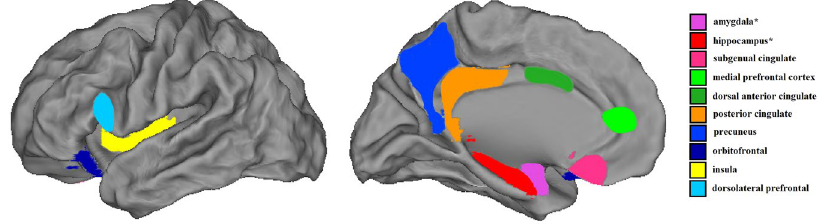
Figure 2. Regions-of-interest. Graphical representation of the regions-of-interest used to extract time series that are the basis the creating the temporal modes. Regions are presented on the left hemisphere. * The right amygdala and hippocampus are not represented but mirror their left